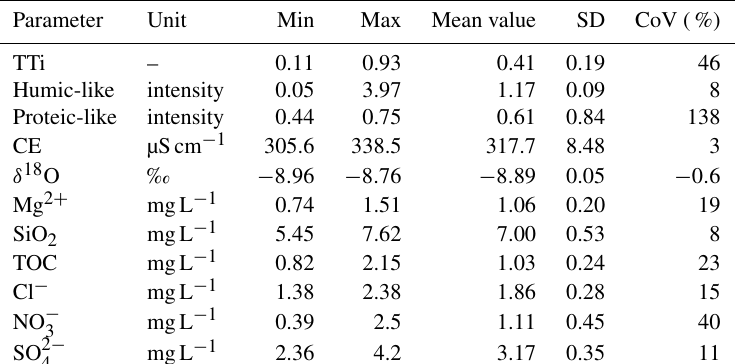
Table 2. Descriptive statistics at Millet spring of major ions, TOC, electrical conductivity, humic-like and protein-like organic matter, and TTi. SD is standard deviation, and CoV is coefficient of variation, over the period June 2020 to October 2021 (29 samples).